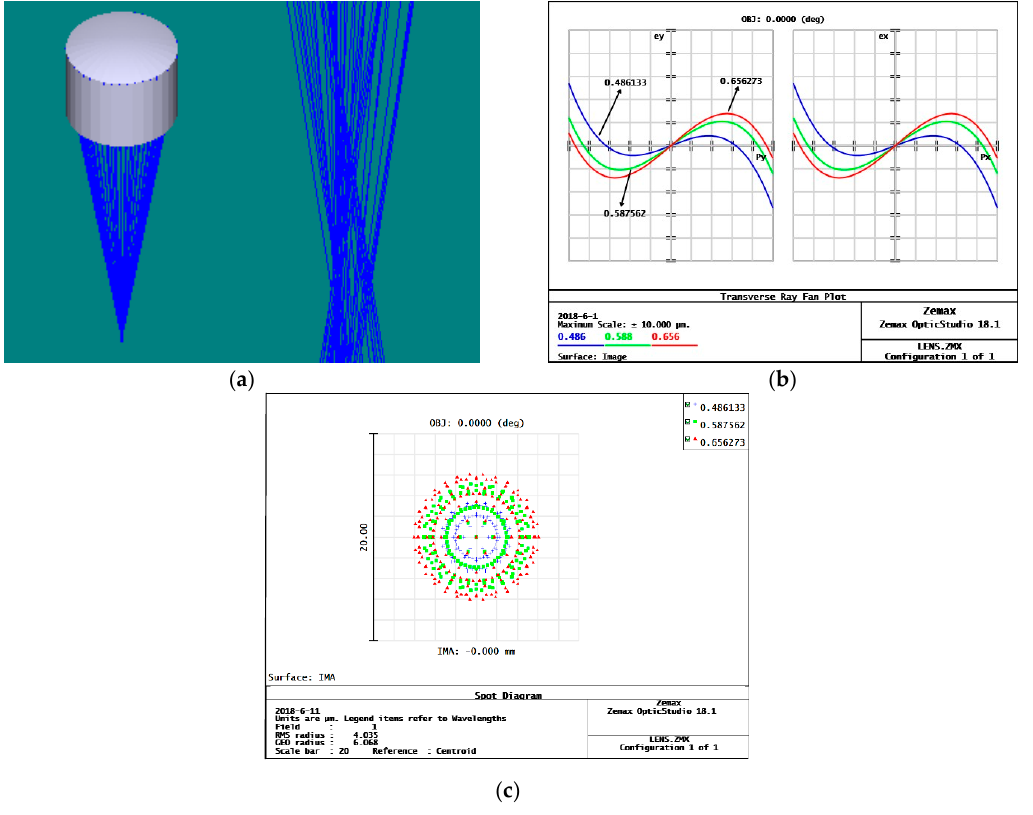
Figure 3. Spherical surface eye point simulation results: ( a ) spherical eye ray tracing; ( b ) spherical eye ray fan image, where p x , p y is the entrance pupil coordinate; e x , e y is the position of the light on the image plane, where the three different colors curves correspond to three different wavelengths of light; ( c ) spherical eye point diagram, where the three different colors point correspond to three different wavelengths of light.